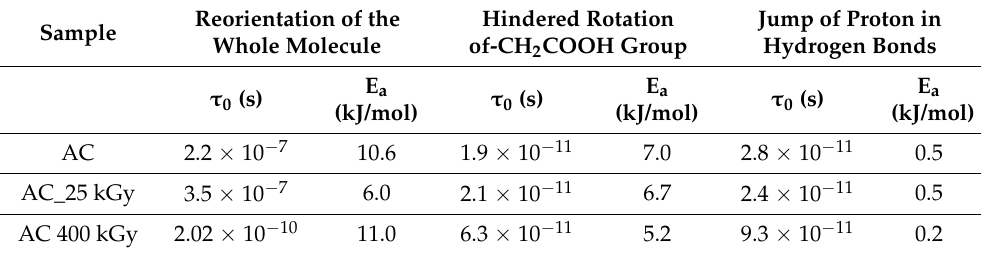
Table 5. Activation parameters of assumed motions obtained for all samples of AC. The values of uncertainty of the estimated parameters were lower than 10%.